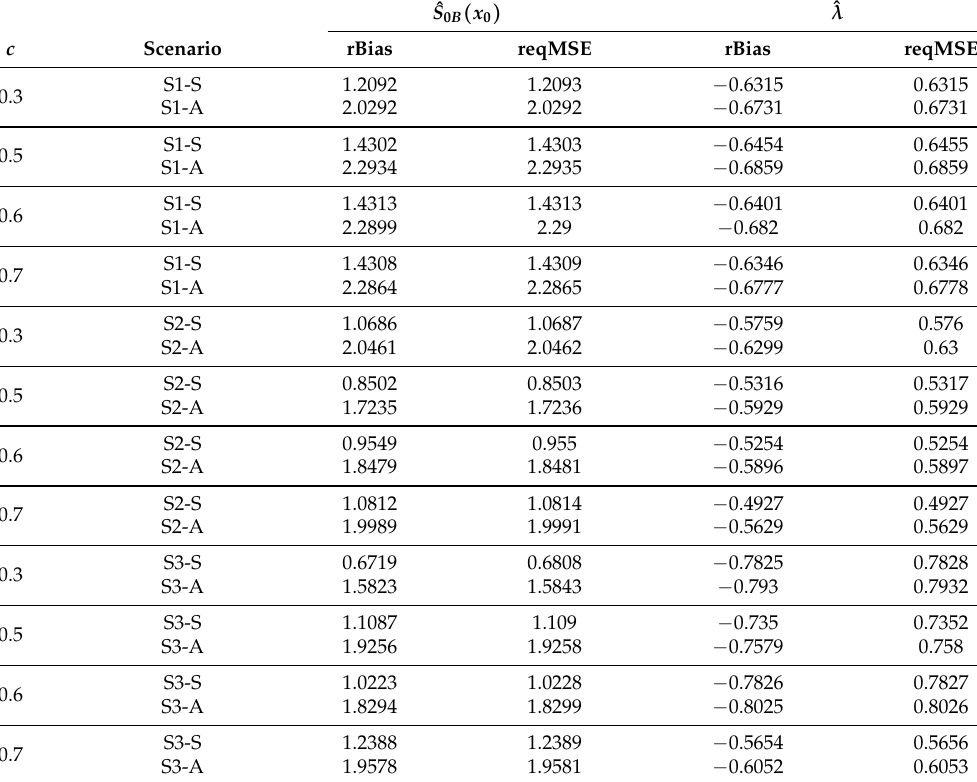
( 0.8 ) and ˆ λ for n = 0